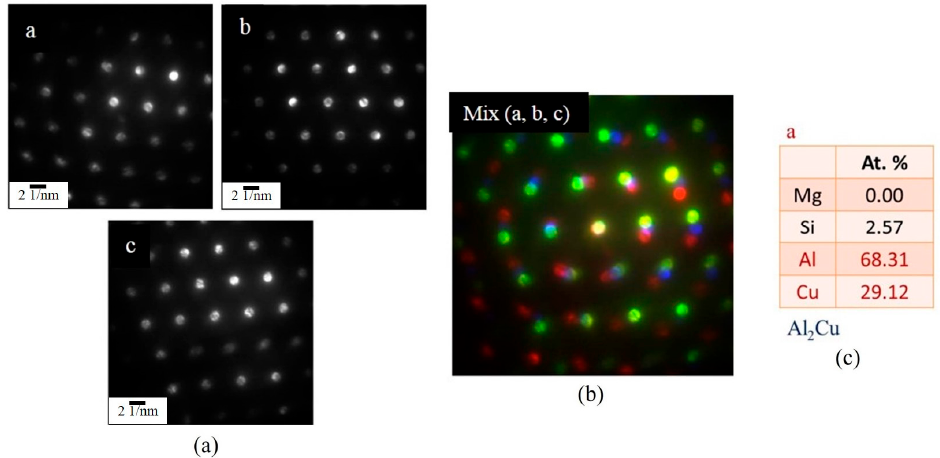
Figure 12. Diffraction patterns of phases at Cu-rich globule boundaries ( a ) diffraction patterns taken at three points (a, b and c); ( b ) merging of above three diffraction pattern; ( c ) composition of phases analyzed by EDS.